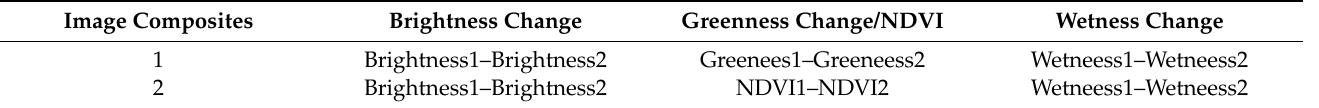
Table 2. Composition of different change composites used for classification purposes. Image